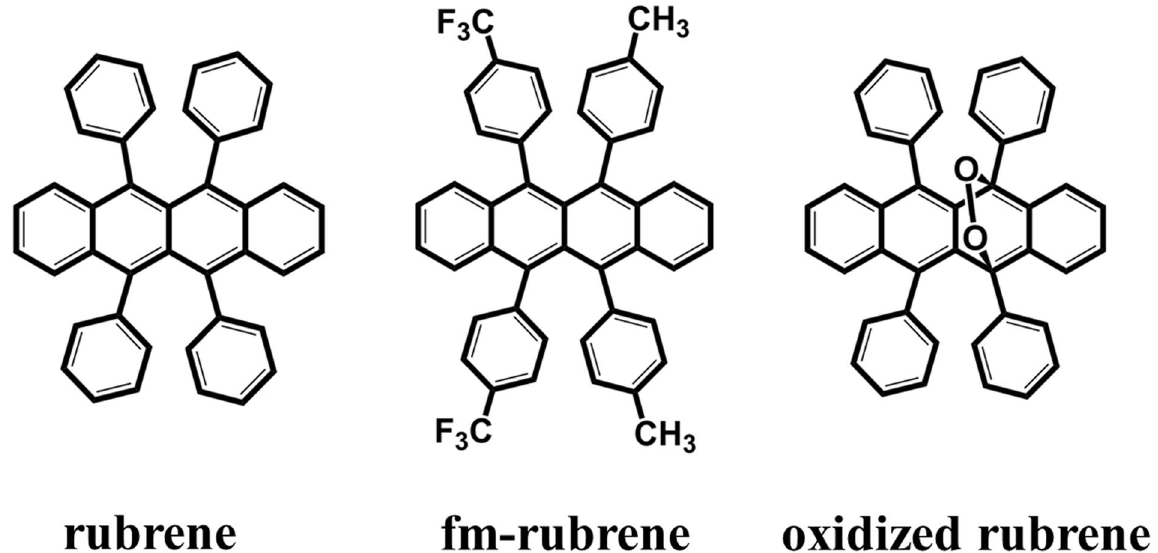
Figure 1. Molecular structures of rubrene, fm-rubrene, and oxidized